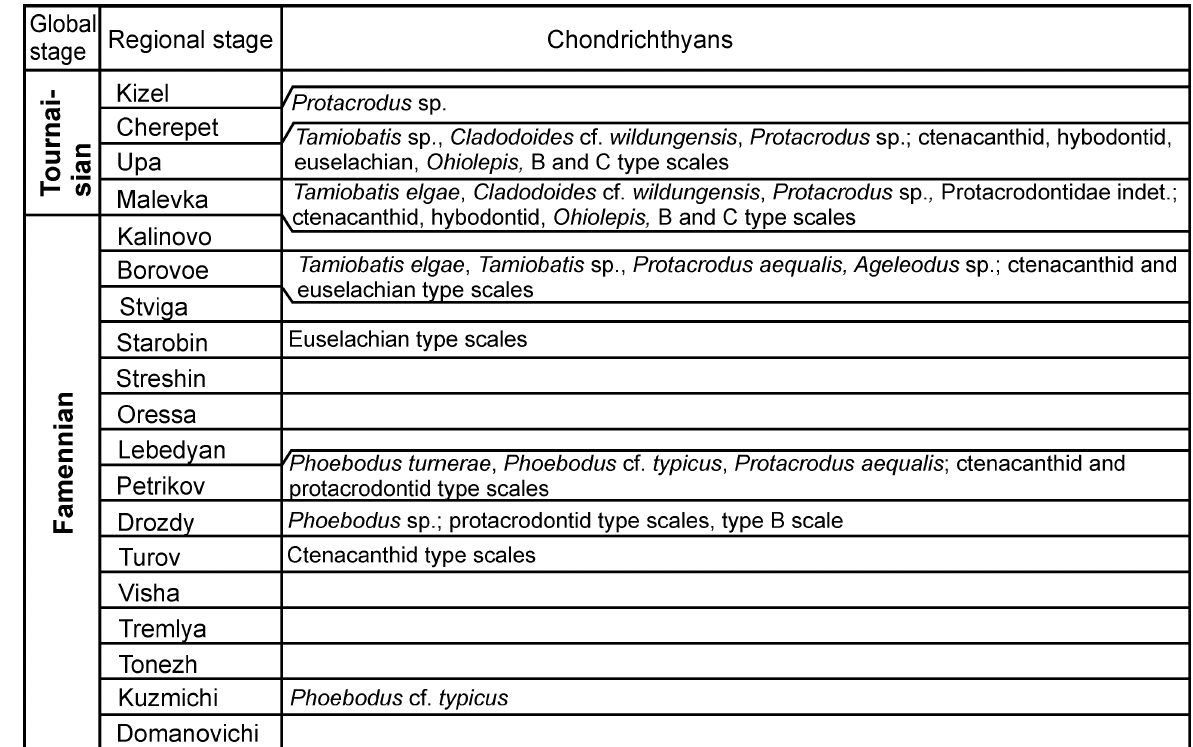
Fig. 7. Distribution of chondrichthyans in the Upper Devonan (Famennian) and Lower Carboniferous (Tournaisian) of Belarus (stratigraphic chart after Kruchek et al.